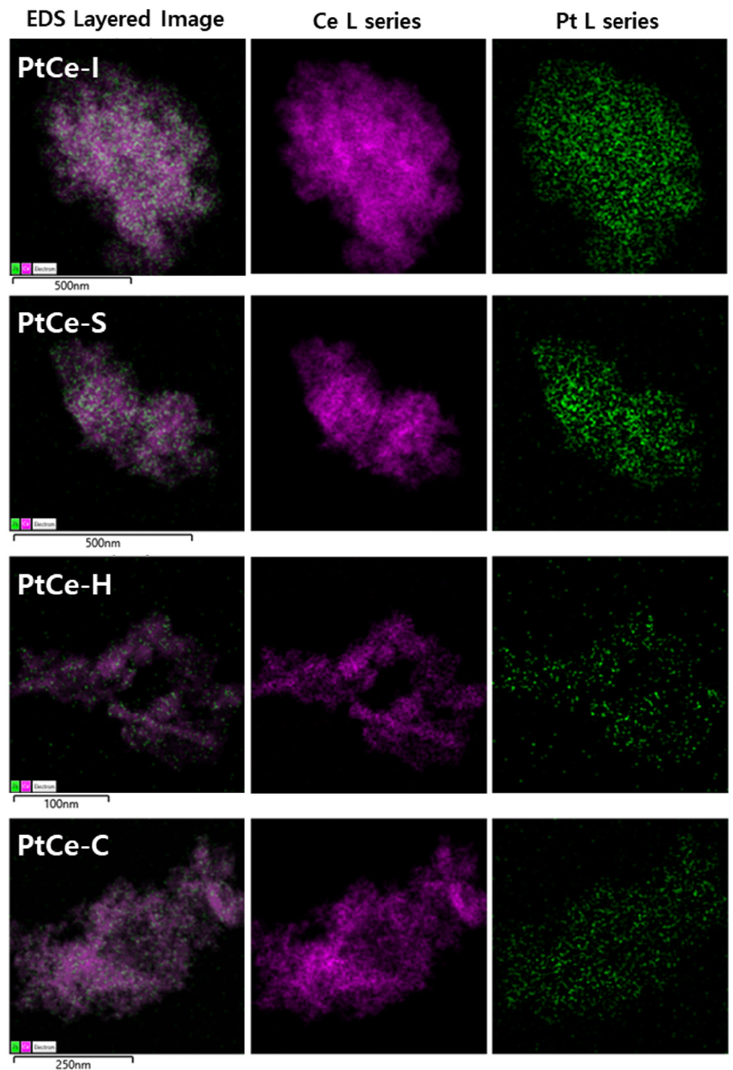
Figure 5. TEM images and EDS mapping results of reduced CeO 2 -supported Pt catalysts prepared by various synthesis methods.